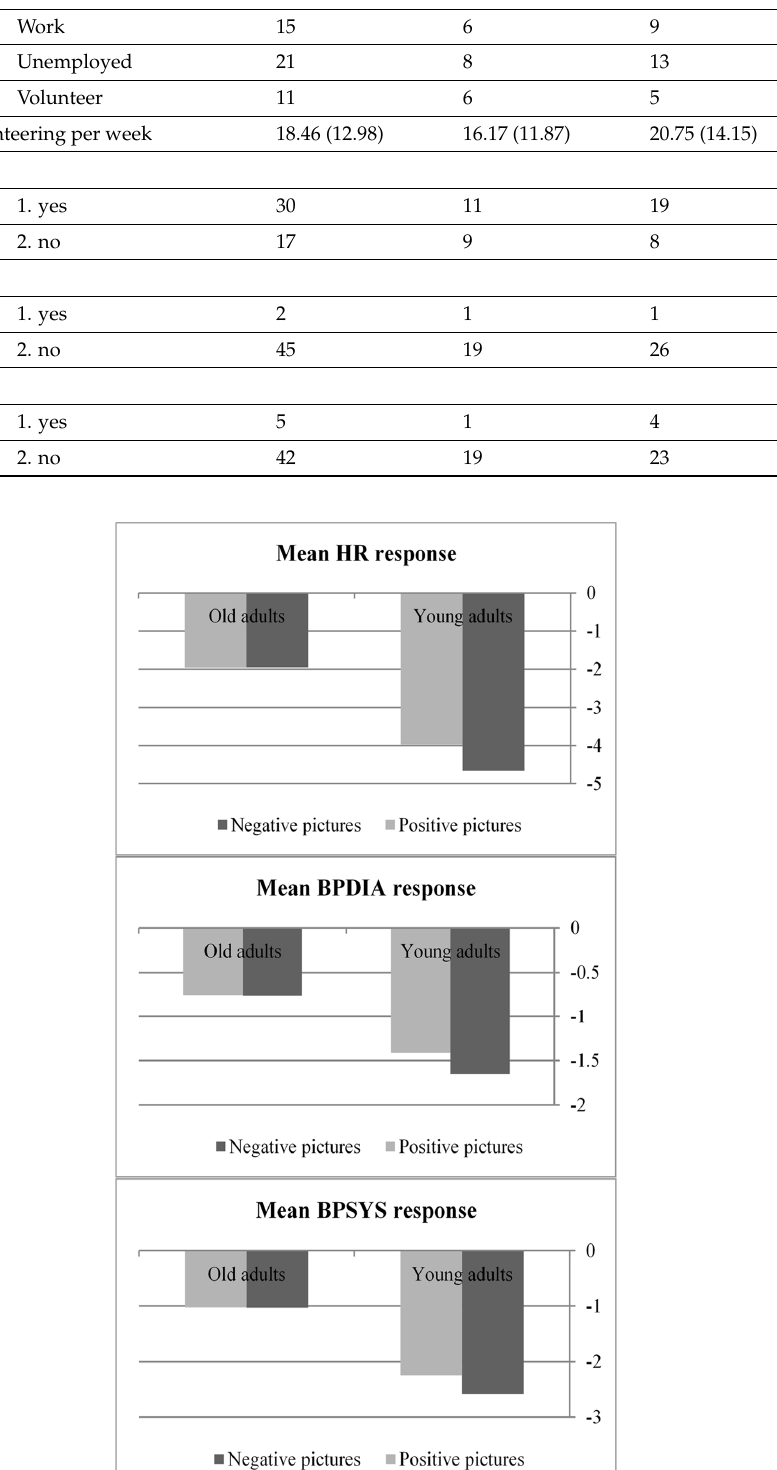
Table A5. Means, standard deviations (SD), statistical parameters, and significance levels of the BPQSF subjective ratings in experiments 1 and 2.